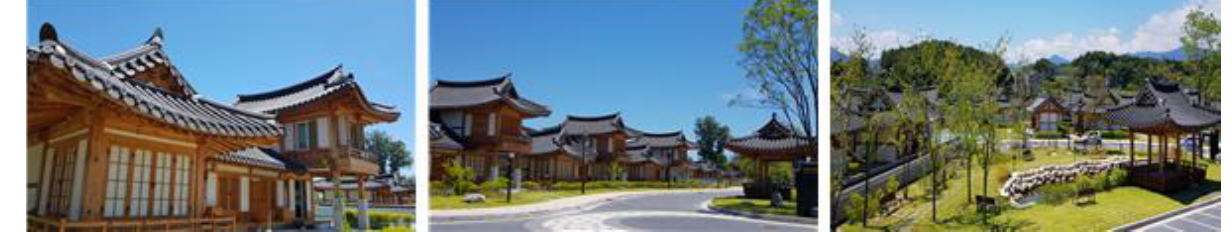
Figure 1. Hanok as a Korean traditional building.